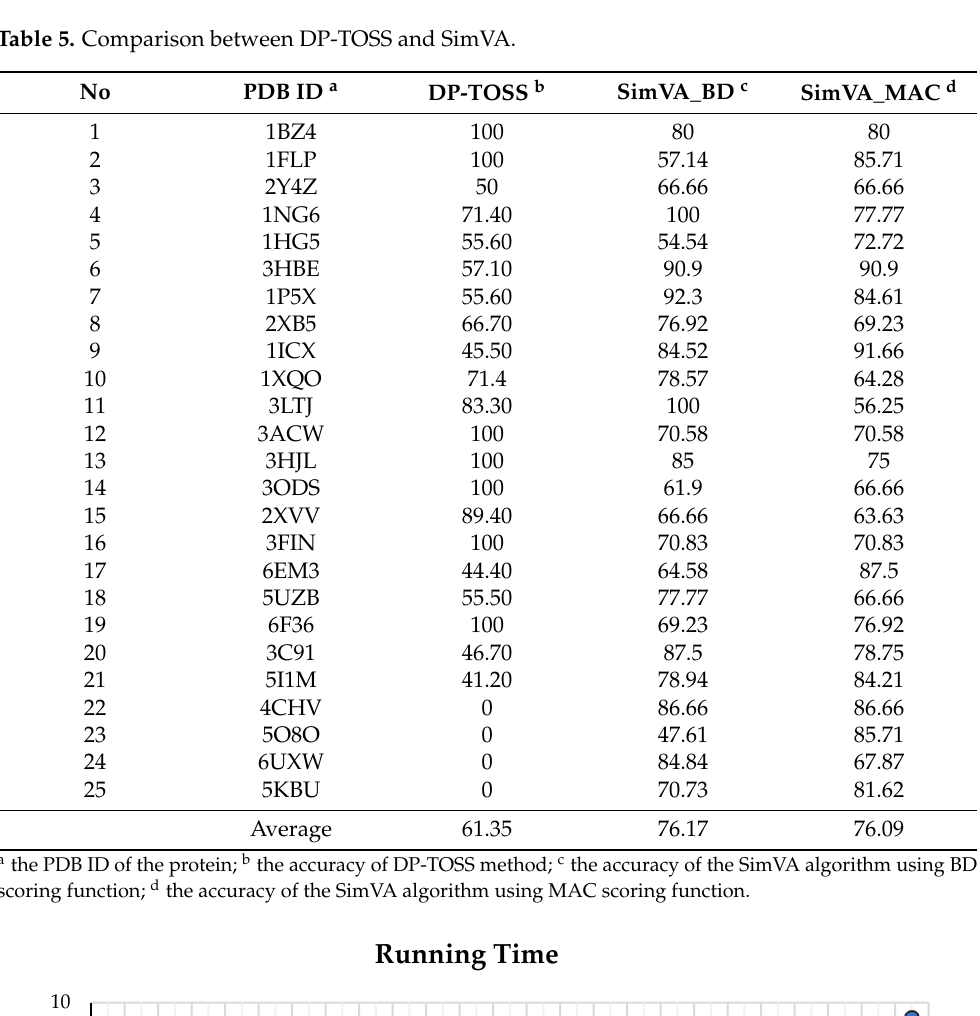
Table 5. Comparison between DP-TOSS and SimVA.